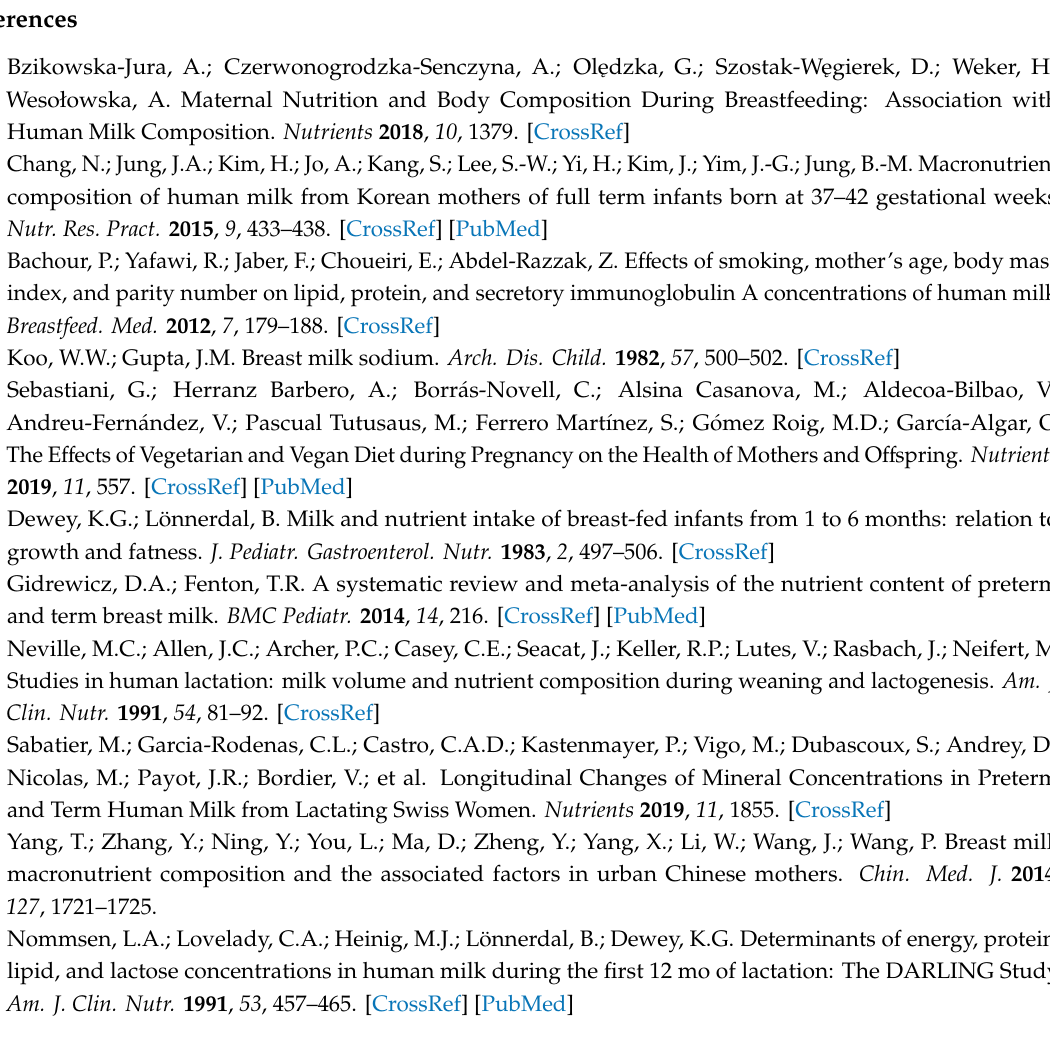
Table S1: Nutrient contents of human milk according to maternal age, Table S2: Nutrient contents of human milk according to milk volume, Table S3: Nutrient contents of human milk according to period of